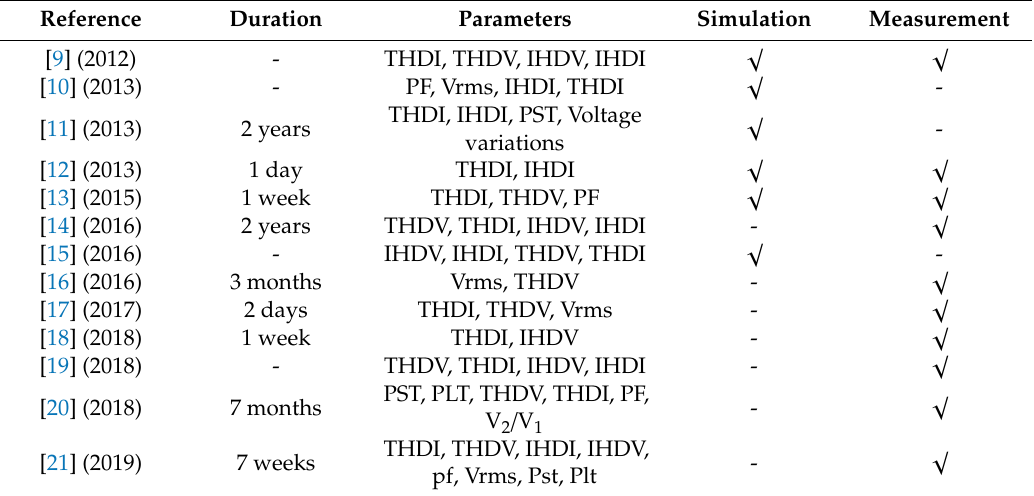
Table 1. Studies related to impact of photovoltaic (PV) systems on power quality (PQ) parameters.